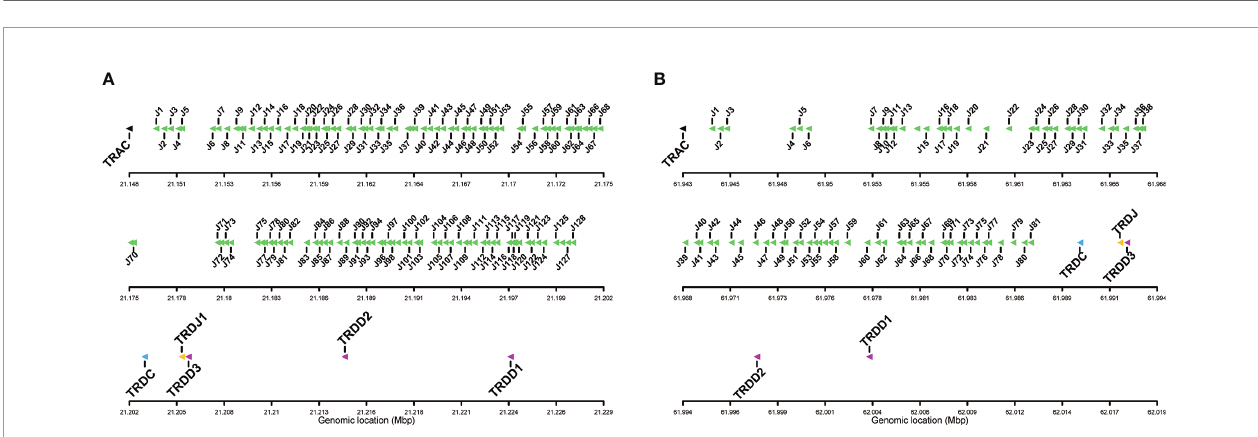
FIGURE 1 | Organization of TRA/TRD locus in salmonids. (A) Atlantic salmon ( Salmo salar ) and (B) rainbow trout ( Onchorynchus mykiss , Arlee strain). TRAV gene names are according to IMGT nomenclature (4, 33). Functional and ORF TRAV genes are in red. TRAV pseudogenes with frameshift(s) in the V-REGION are in grey and their name are not displayed. The arrow indicates the orientation. The symbols representing the genes are not to scale. Information about gaps (length and location) is available in Supplementary Data 3 .